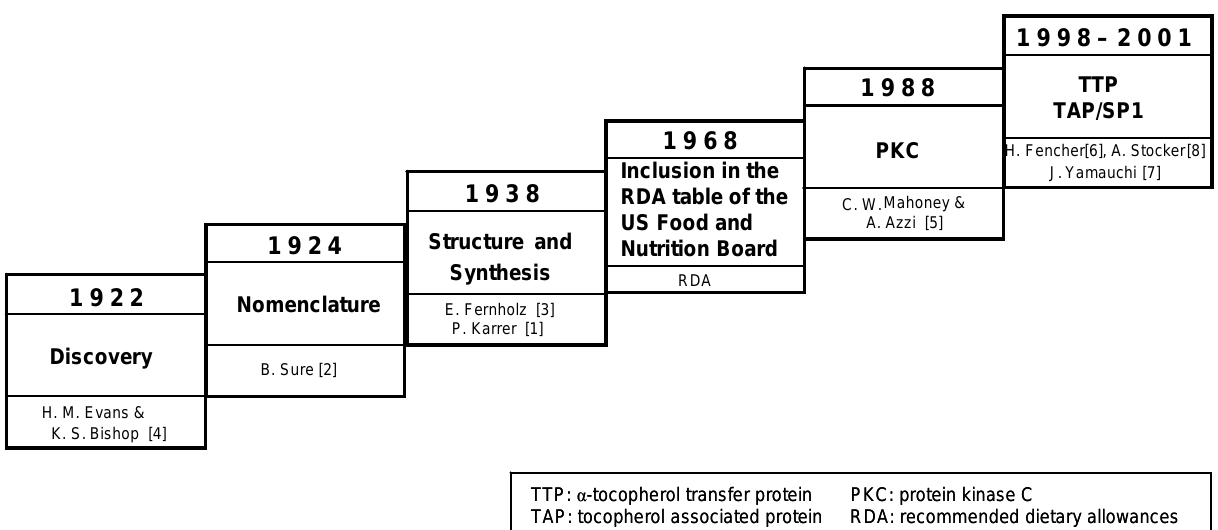
Figure 1. Milestones in vitamin E